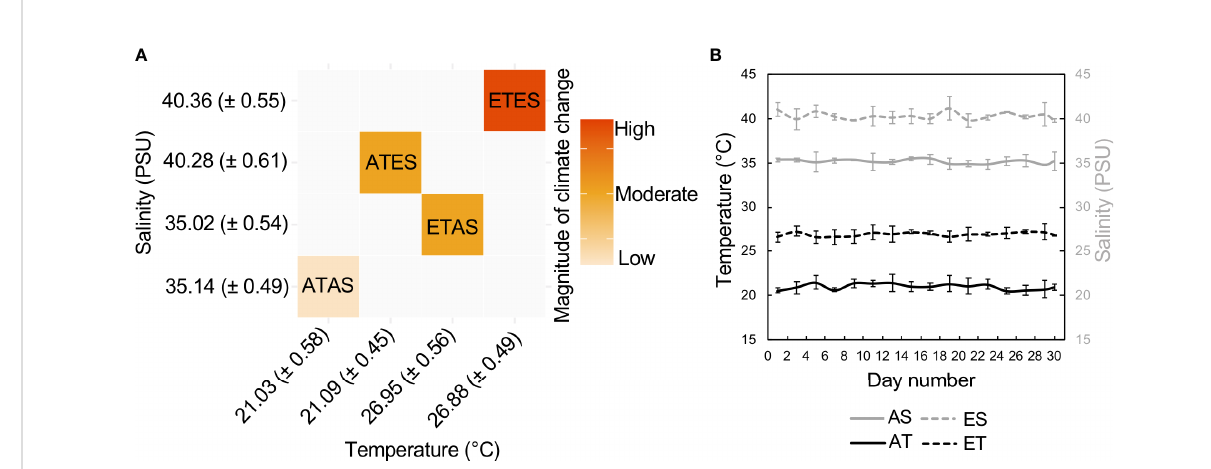
FIGURE 1 (A) Mean water temperature and salinity (± SD, n = 14 per treatment) of treatments during the 30-day experimental period. (B) Time-series of temperature and salinity levels measured every second day during the experiment (bars denote ± SD). Treatments range from a low magnitude climate change scenario to moderate and high magnitude scenarios, and are coded as follows herein: ATAS, ambient temperature and salinity; ATES, ambient temperature and elevated salinity; ETAS, elevated temperature and ambient salinity; and ETES, elevated temperature and salinity. Dissolved oxygen (mg l -1 ) was measured every second day and remained consistent among replicates during the experimental period: ATAS = 8.62 ( ± 0.34), ATES = 8.78 ( ± 0.40), ETAS = 8.46 ( ± 0.47), ETES = 8.88 ( ±